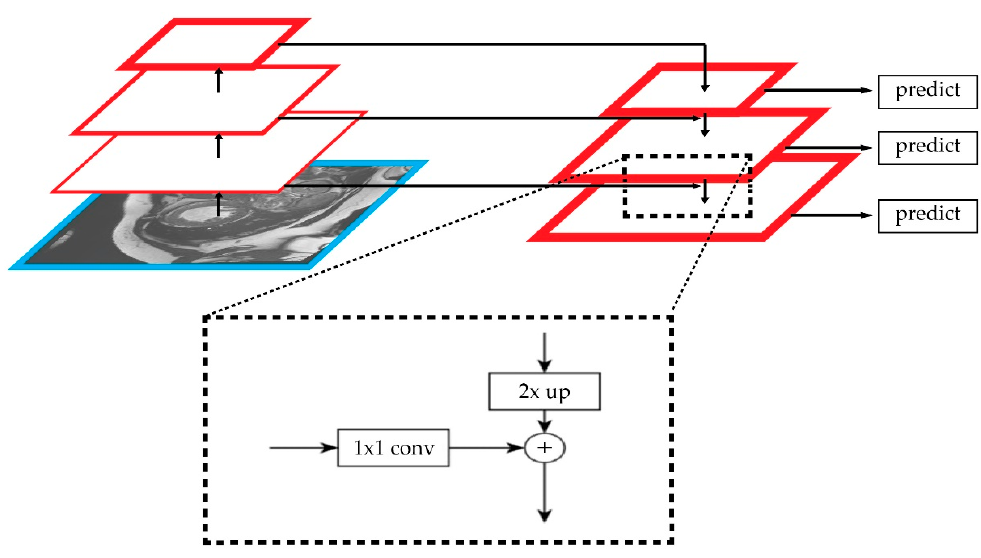
Figure 8. Feature-pyramid-network (FPN) model that combines low- and high-resolution features via a top-down pathway to enrich semantic features at all levels.